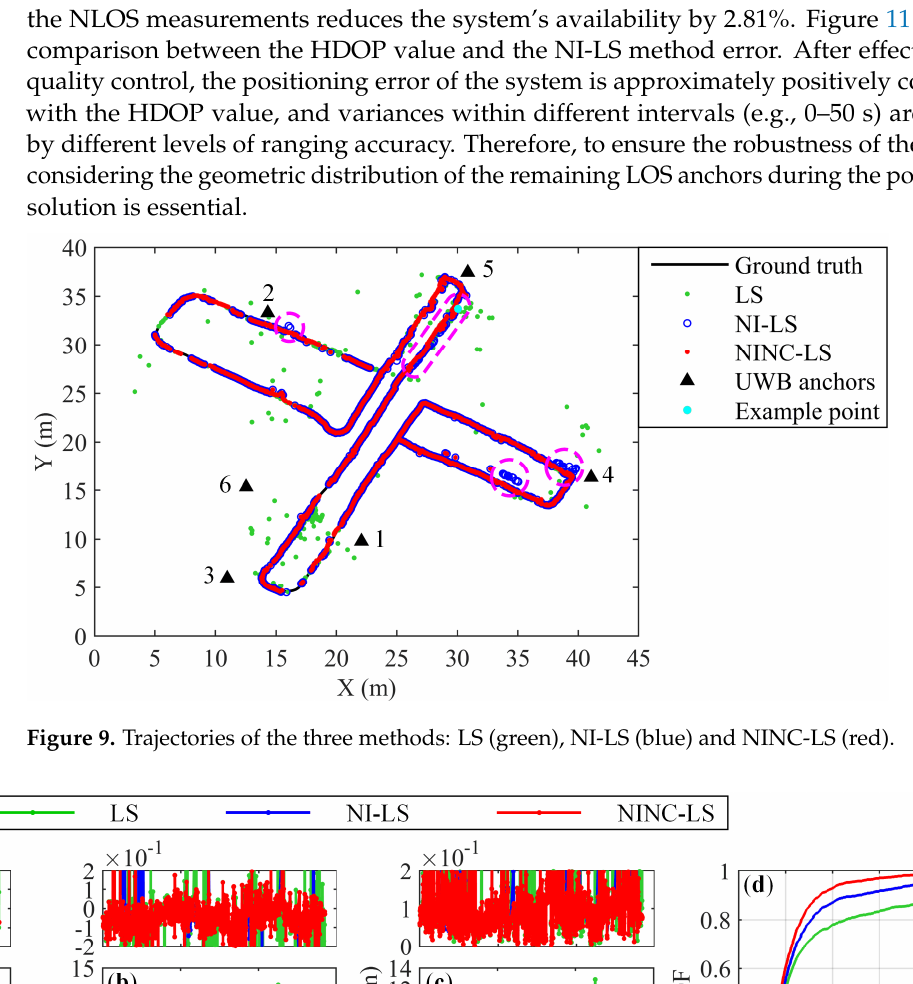
Table 2. Performance of different UWB measurements. Four decimal places are given to better com- pare the difference between the LOS and corrected measurements.